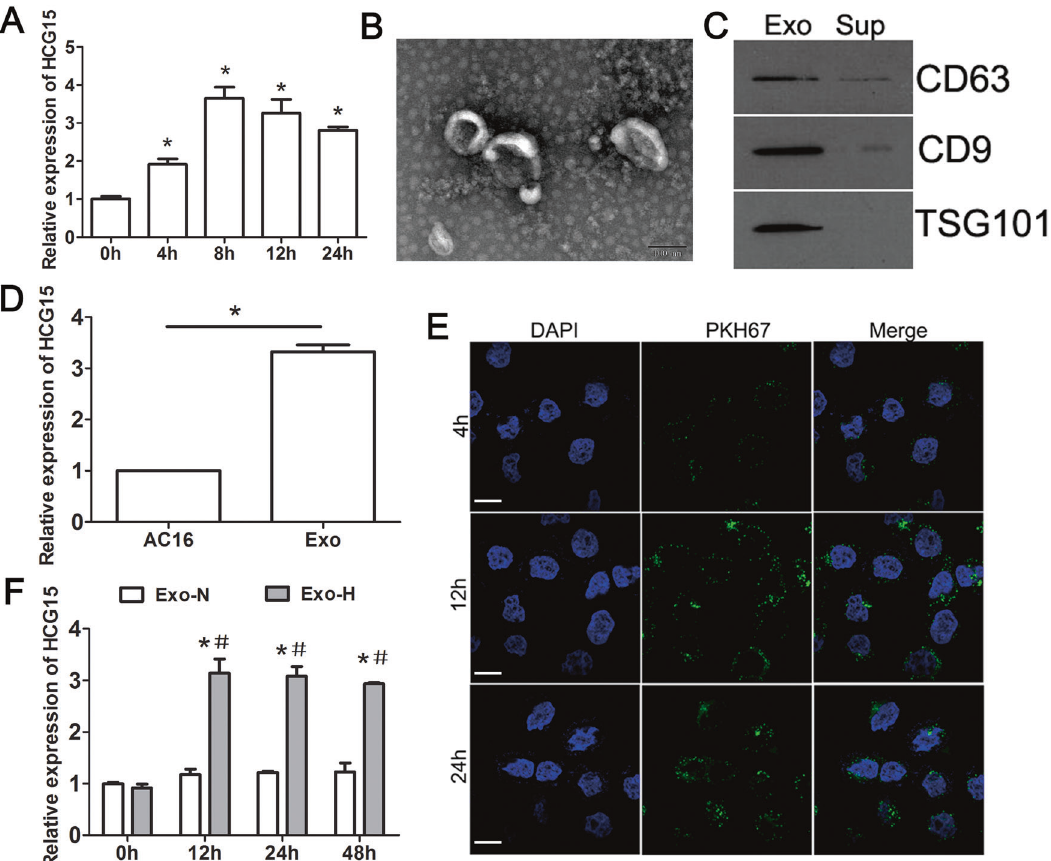
Fig. 3 HCG15 carried by exosomes was transferred to cardiomyocytes after hypoxia. A qRT-PCR detected the expression of HCG15 in hypoxic AC16 cells. B Exosomes isolated from hypoxic AC16 cells are shown by TEM. C Western blotting was used to detect the expression of biomarkers in the exosome (Exo) and supernatant fractions (Sup) of the medium from AC16 cells after 8 h of hypoxia. D qRT-PCR was used to detect the level of HCG15 in exosomes and their producers (AC16 cells) after hypoxic treatment. E Confocal microscopy showed that PKH67- labeled exosomes from hypoxic AC16 cells were taken up by AC16 cells at different times. The nuclei were stained with DAPI; green: PKH67 (the magni fi cation was × 400). F Expression of HCG15 in AC16 cells after incubation with Exo-N and Exo-H at different times was detected